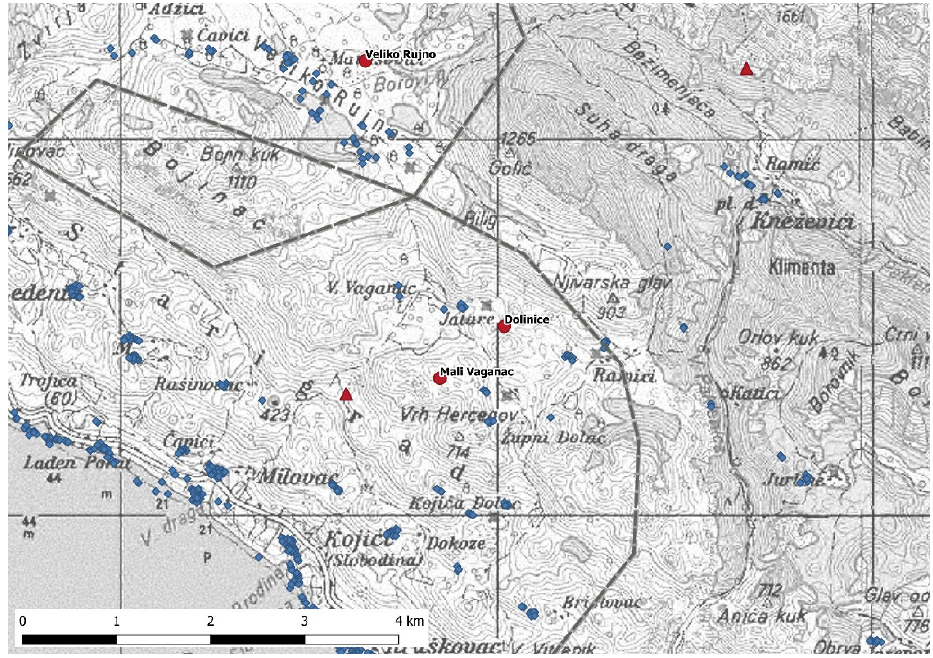
Figure 3. The three artificial feeding sites (red dots) are located close to the border of the National Park (dark grey dashed line) and to settlements (blue squares). Red triangles show denning sites of the two bears. Scale: 1:33,000.